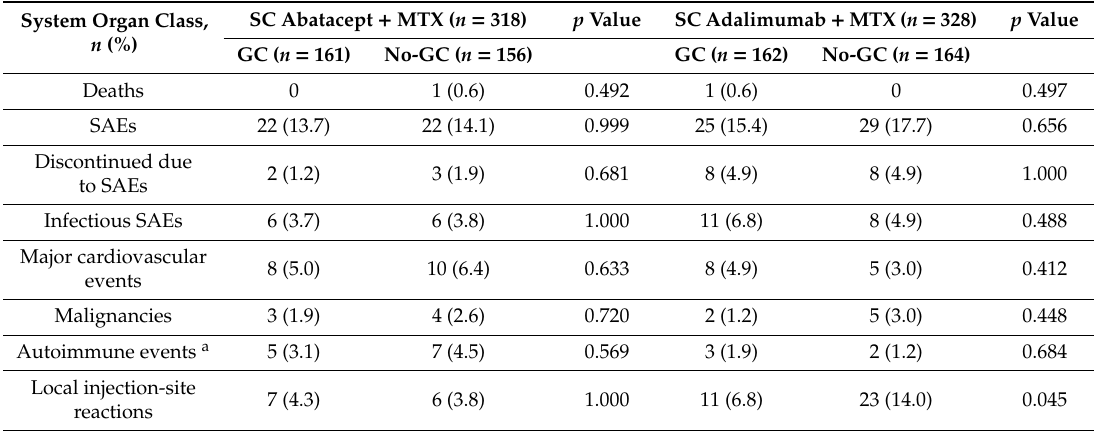
Table 3. Summary of patients with adverse events reported over 2